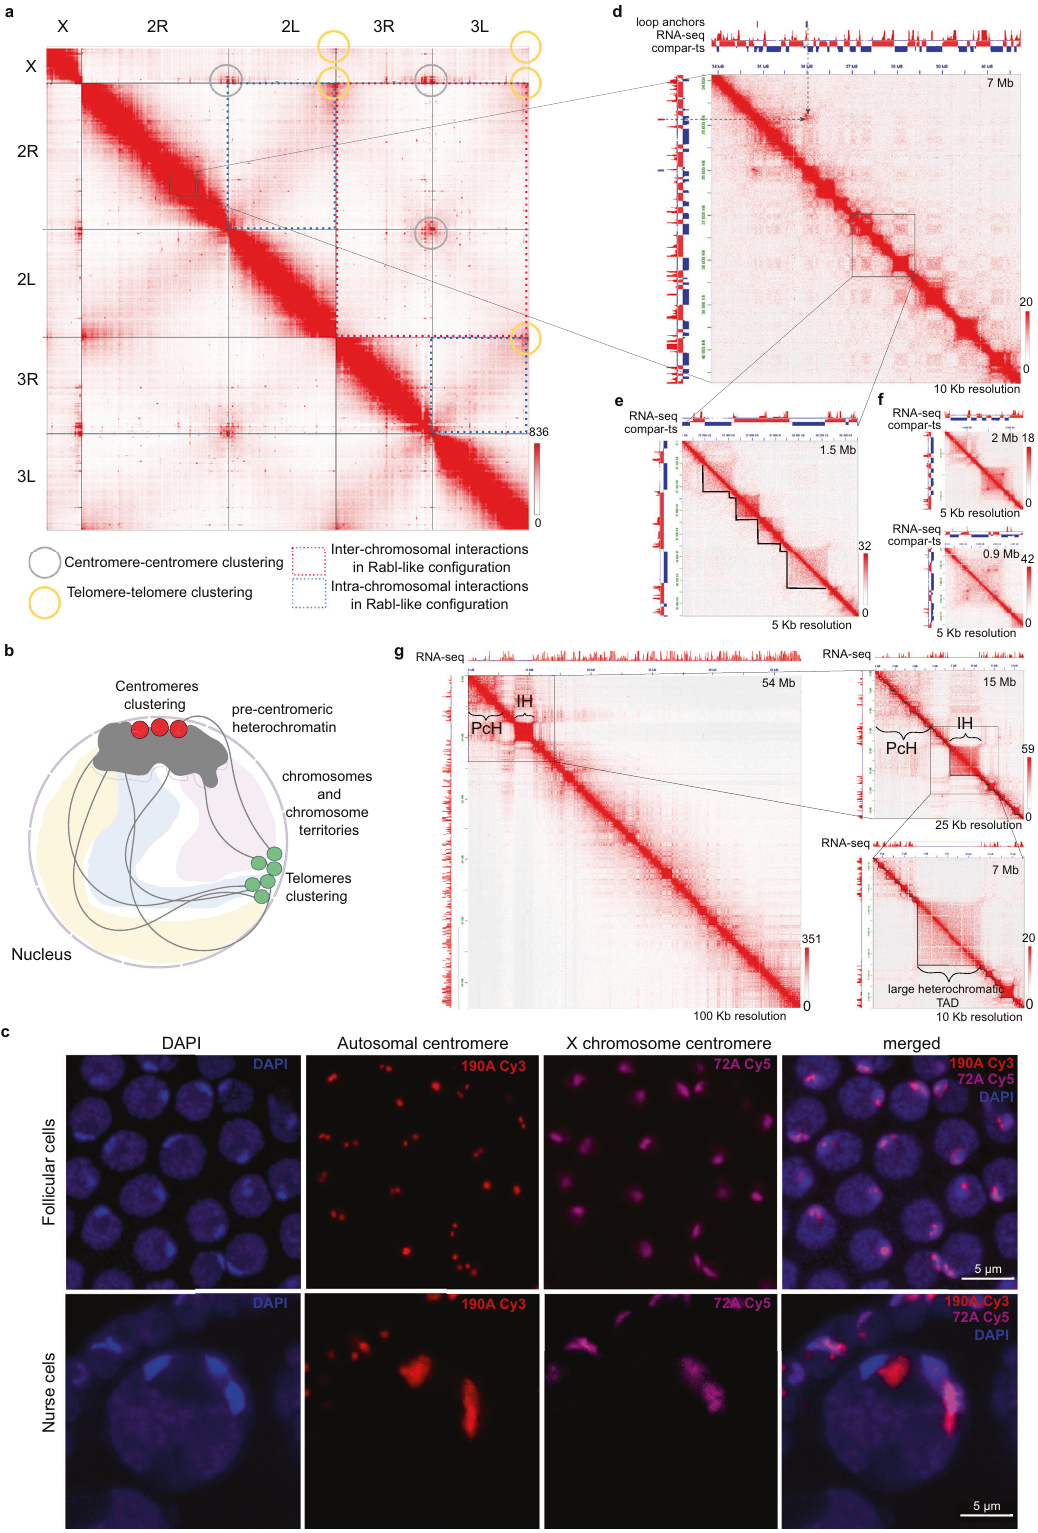
Fig. 4 3D chromatin structure of Anopheles mosquito genomes. a A Hi-C contact map for An. albimanus ; gray and yellow circles correspond to contacts between telomeres and centromeres, respectively; b Schematic representation of Rabl-like con fi guration; c FISH showing position of centromeres: 190A Cy3 probe — autosomal centromere, 72A Cy5 probe — Chr X centromere; n = 144 for follicular cells, n = 8 for nurse cells; d – g Zoomed-in Hi-C map regions showing long-distance loops between TADs ( d indicated by arrows), compartments ( d ), TADs ( e ), loops within TADs ( f ), and heterochromatic blocks either located near centromeres (PcH) or interspersed throughout the euchromatin (IH) ( g ). Color bars near the heatmaps re fl ect the contact